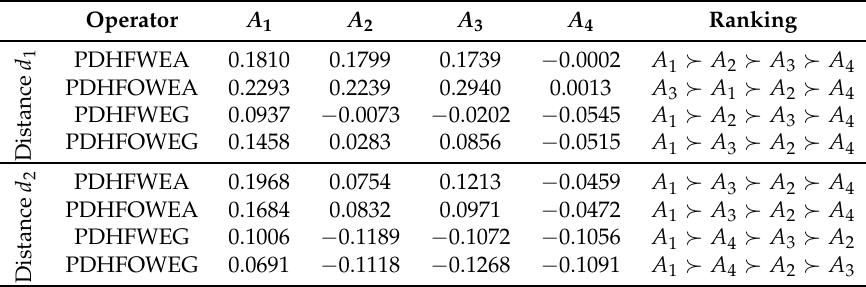
Table 5. Score values of proposed